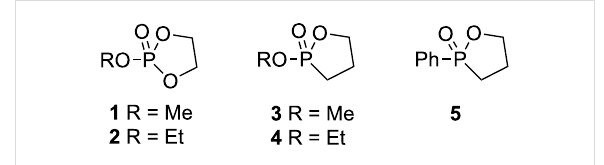
Figure 1: Chemical structures of 2-methoxy-1,3,2-dioxaphospholane 2-oxide ( 1 ), 2-ethoxy-1,3,2-dioxaphospholane 2-oxide ( 2 ), 2-methoxy- 1,2-oxaphospholane 2-oxide ( 3 ), 2-ethoxy-1,2-oxaphospholane 2-oxide ( 4 ), and 2-phenyl-1,2-oxaphospholane 2-oxide ( 5